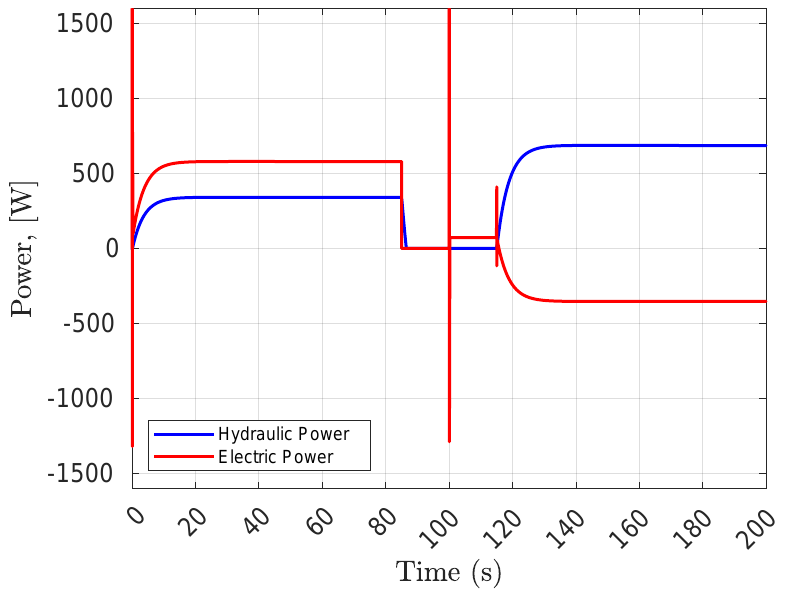
Figure 6. Power transformation of third scenario: The system works in pumping mode at t taking energy from the electric network, which is converted into mechanical (hydraulic) energy. Both hydraulic and electromechanical systems are switched off between 85 < t < 100 ( s ) . At t = 100 ( s ) , the asynchronous machine is switched on again in the motor mode, taking energy from the electric network. Then, at t = 115 ( s ) , the hydraulic system is also switched on, inducing the system to start its operation in the generator-turbine mode. Subsequently, mechanical energy is converted into electrical energy, which is supplied to the power grid. The initial conditions are Q ( 0 ) = 0.0 ( m 3 / s ) , P r ( 0 ) = 3.1825 10 5 ( Pa ) , and h w = 32.5 ( m ) ×